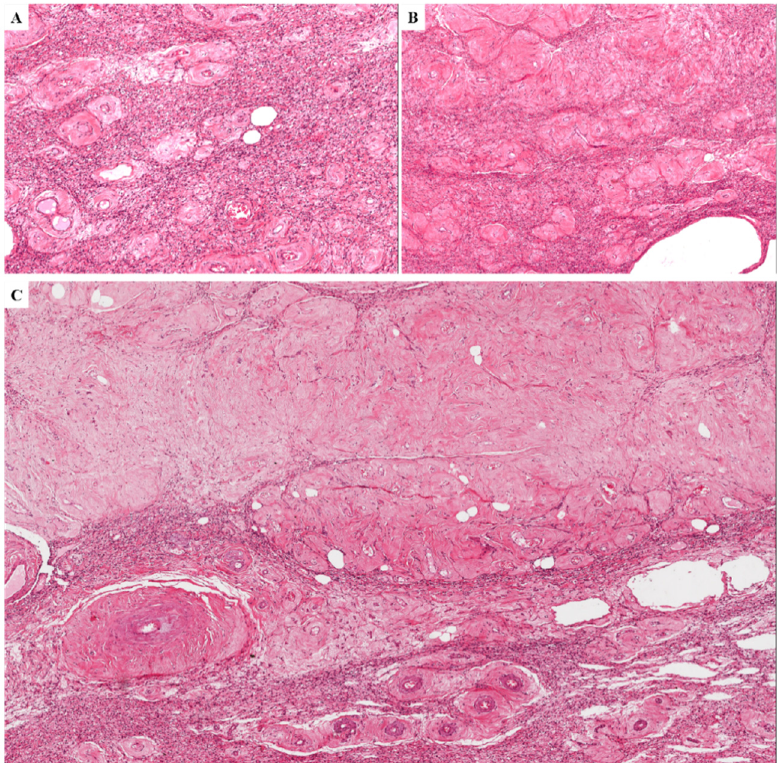
Figure 12. Recurrent DAM . ( A , B ) Tumor with lumen obliteration of the blood vessels; ( C ) the obliterated vessels form confluent nodular structures reminiscent of ovarian corpora albicantia.